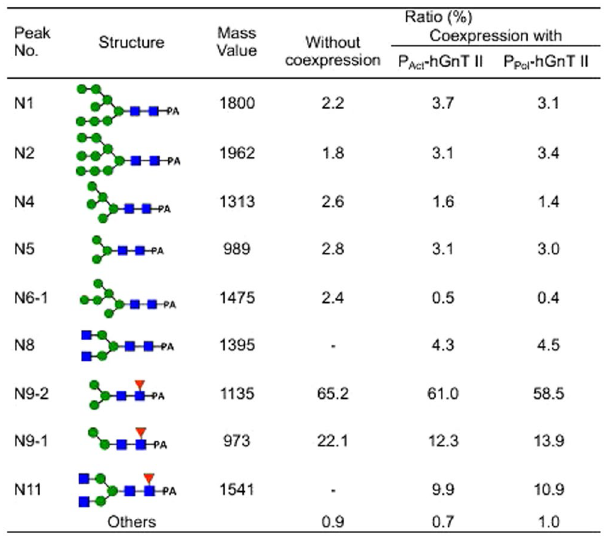
Figure 4. N -glycan structures of hIgG coexpressed with hGnT II in silkworm pupae.